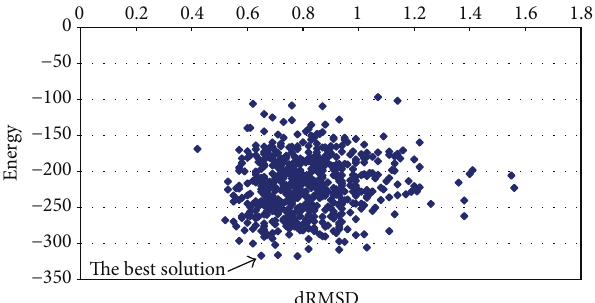
Figure 9: Graphic of average energy and dRMSD (T0549 instance).